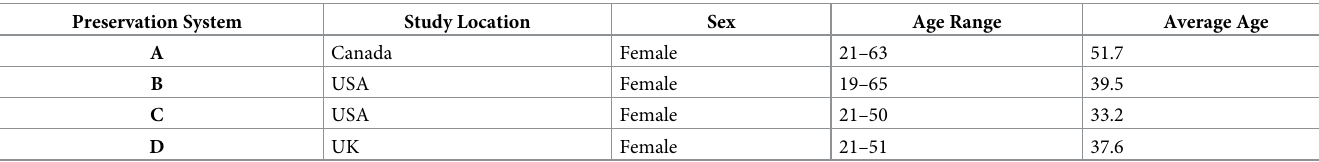
Table 2. Summary information for cohorts of subject used for subsequent analysis. Preservation